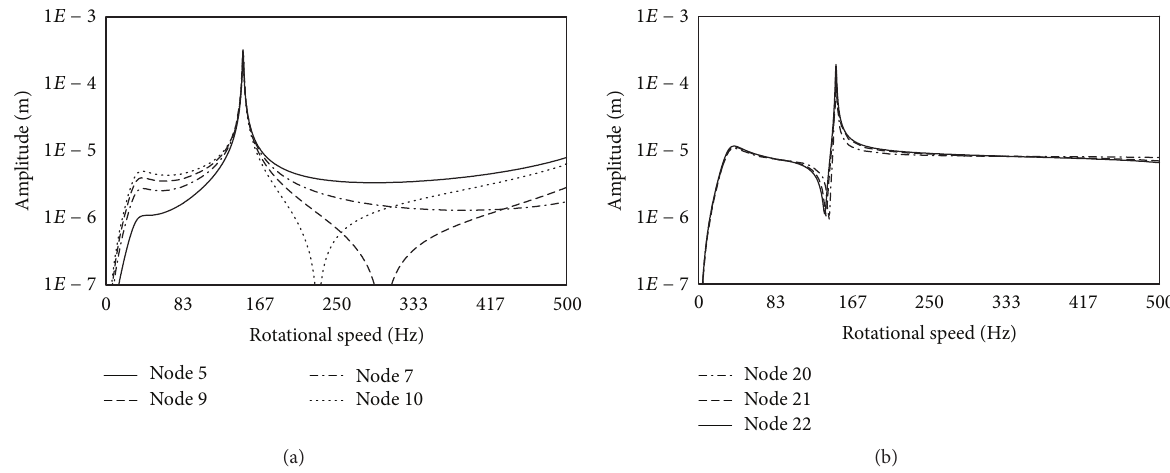
Figure 10: Unbalanced responses of the rotor-bearing system for the radial clearance of the squeeze film damper equal to 0.1905